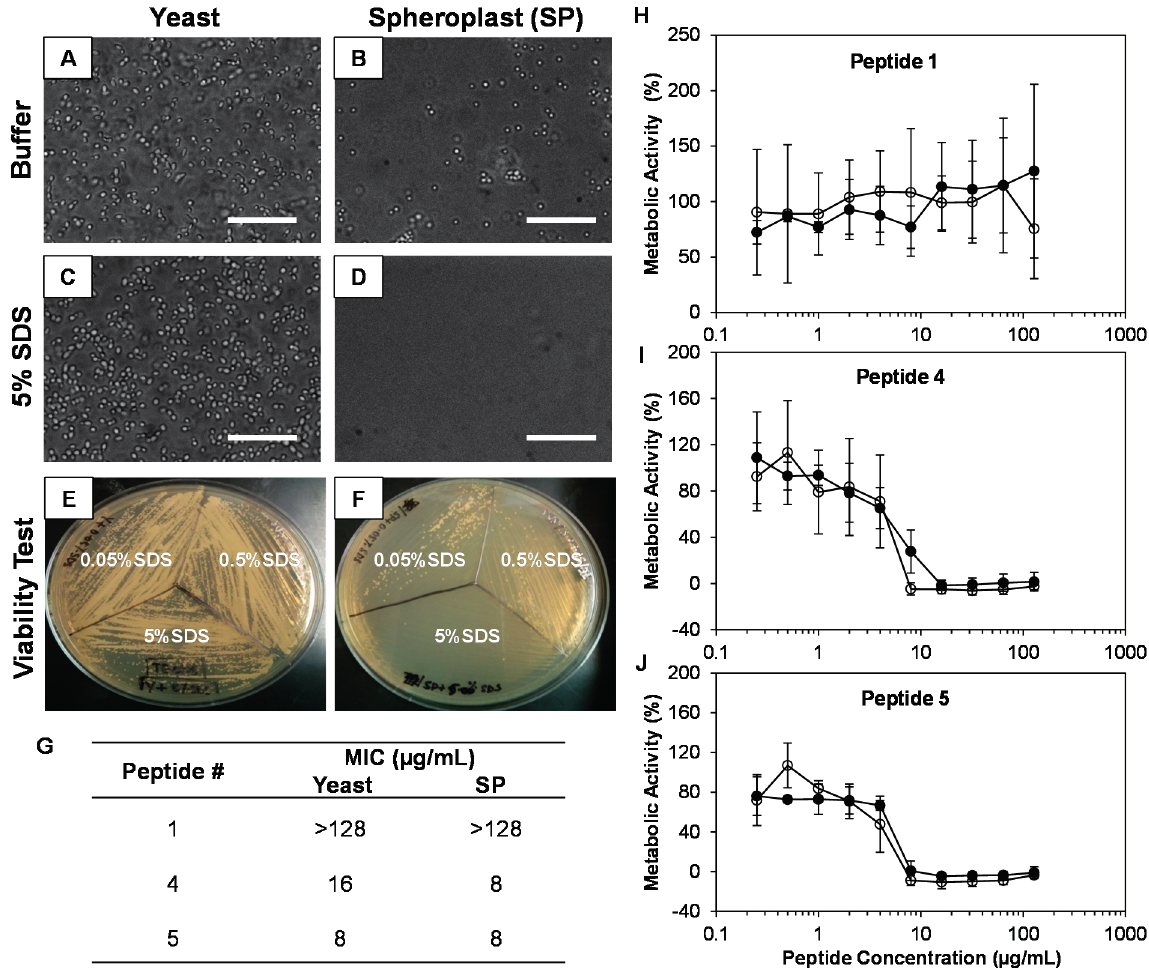
Figure 4. β -peptide activity against C. albicans spheroplasts (SPs). ( A – D ) Phase contrast microscopy of overnight cultures of yeast ( A , C ) or after cell wall removal to yield SPs ( B , D ) in buffer solution ( A , B ) and in the presence of 5% SDS ( C , D ). Scale bars = 50µm. Agar plates showing viability of yeast ( E ) and spheroplasts ( F ) in the presence of increasing concentrations of SDS. ( G ) Comparison of the MICs of C. albicans yeast and SPs against β -peptides. ( H – J ) Plots of concentration-dependent growth inhibition of C. albicans yeast (black circles) and SPs (white circles) by β -peptides 1 , 4 and 5 . C. albicans yeast cells and SPs (10 3 cells/mL) were incubated with β -peptides for 48 h and β -peptide susceptibility was assessed using an XTT assay to compare the absorbance at 490 nm for β -peptide-treated samples and untreated samples. Data points are the average of two independent